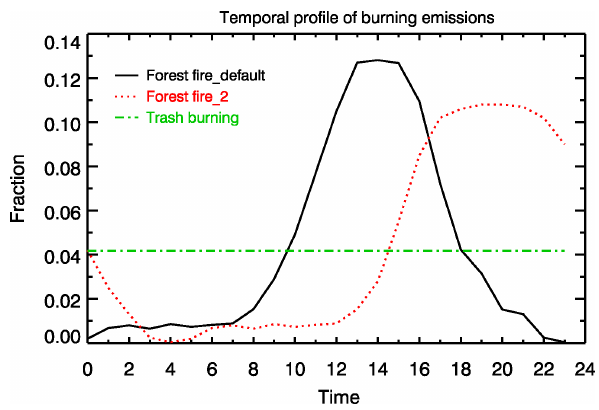
Fig. 2. Diurnal profiles of emissions from forest fire and garbage